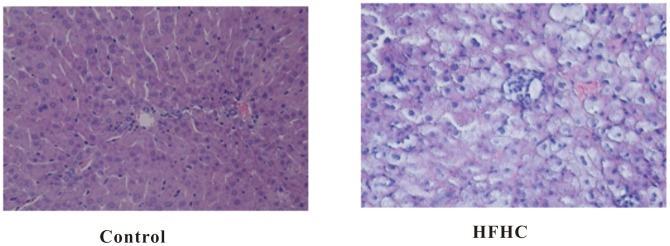
Representative hematoxylin and eosin (H&E) staining of liver sections from control (left) and HFHC hamsters (right) at week 42.Lipid droplets were obviously accumulated in HFHC hamsters, but not control hamsters.